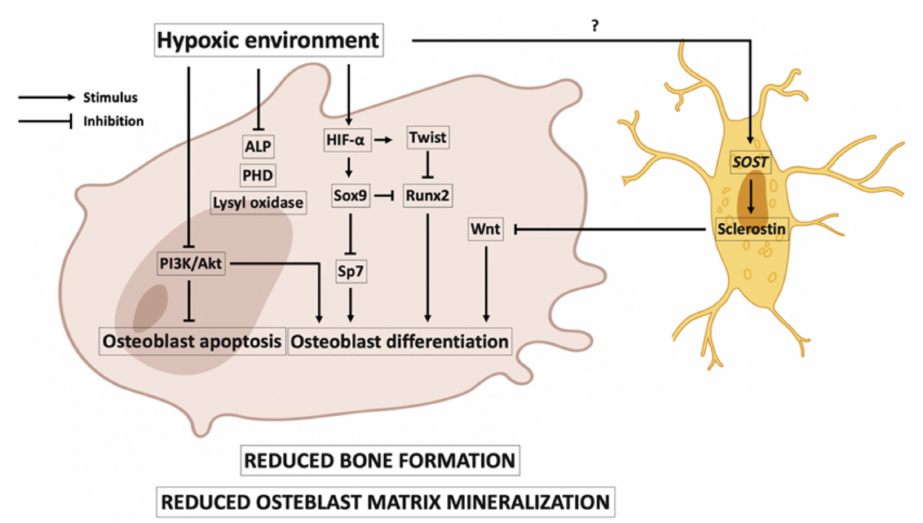
Figure 2. Effects of hypoxia on osteoblasts. A hypoxic environment is associated with a reduction in bone formation and osteoblast matrix mineralization. Hypoxia-inducible factor (HIF)- α is associated with the expression of Twist, which downregulates Runx2 expression and causes a reduction in osteoblast differentiation. Runx2 expression is also reduced by the expression of Sox9, which is promoted by HIF- α . Sox9 factor also reduces the expression of Sp7, another factor involved in os- teoblast differentiation. Hypoxia has also been associated with inhibition of the phosphatidylinositol 3-kinase (PI3K)/Akt pathway, favoring osteoblast apoptosis. In a hypoxic environment, in osteocytes, there could be an increase in SOST gene expression and therefore an increase in the expression of the sclerostin protein, inhibiting the Wnt pathway and thus, osteoblast differentiation. In hypoxia, reduced osteoblast matrix mineralization is associated with reduced activity of prolyl hydroxylase domain (PHD), lysyl oxidase oxygen, and alkaline phosphatase